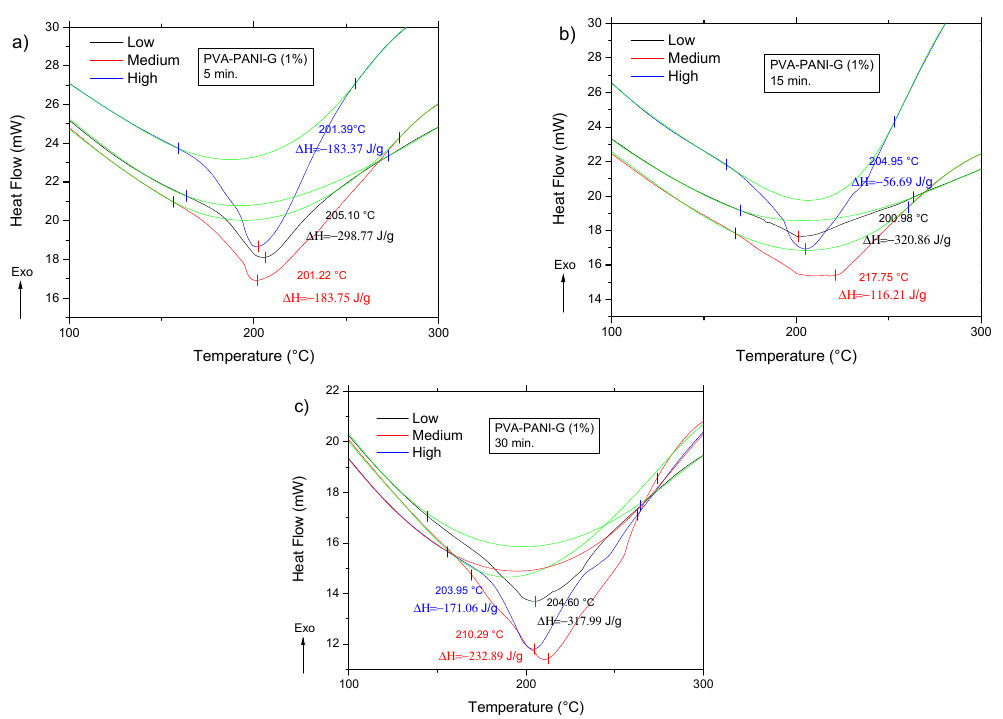
Figure 14. DSC thermograms of purified PVA–PANI-G gels, activated with 1% GA for ( a ) 5 min, ( b ) 15 min, and ( c ) 30 min.